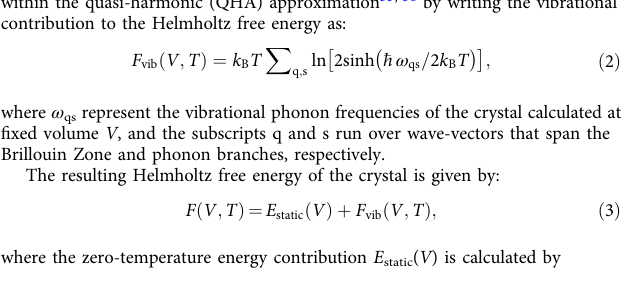
Phonon dispersion curves . First-principles density functional theory calculations were performed using VASP 51, 52 and the so-called direct method 53 , where com-